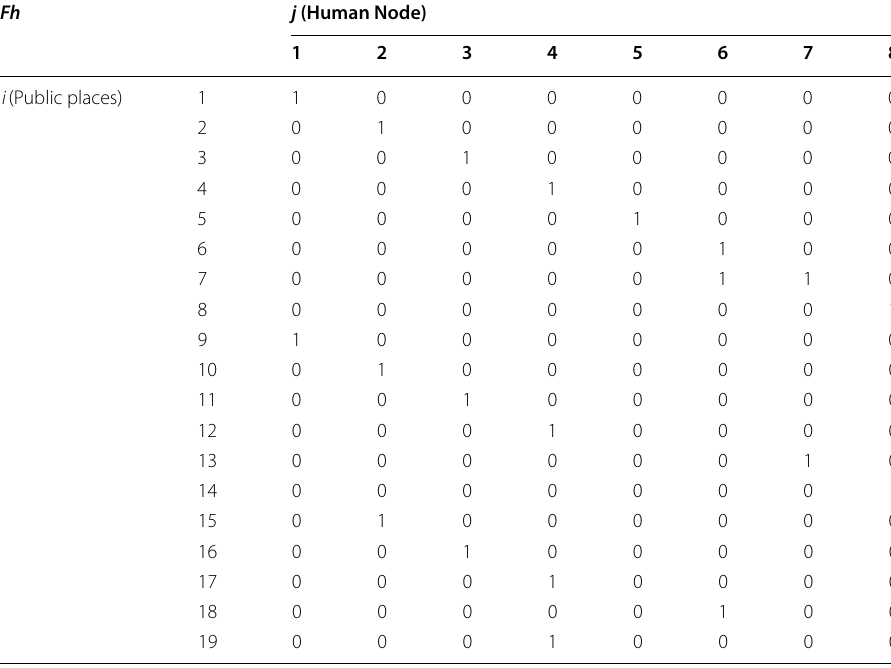
Table 3 Values of Fh for human nodes for BDC Network ij Fh j (Human